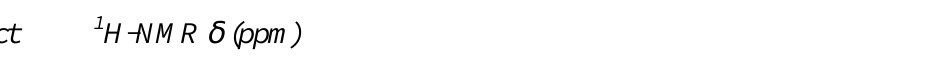
Table 2. 1 H-NMR Spectral Data of 3-7 and